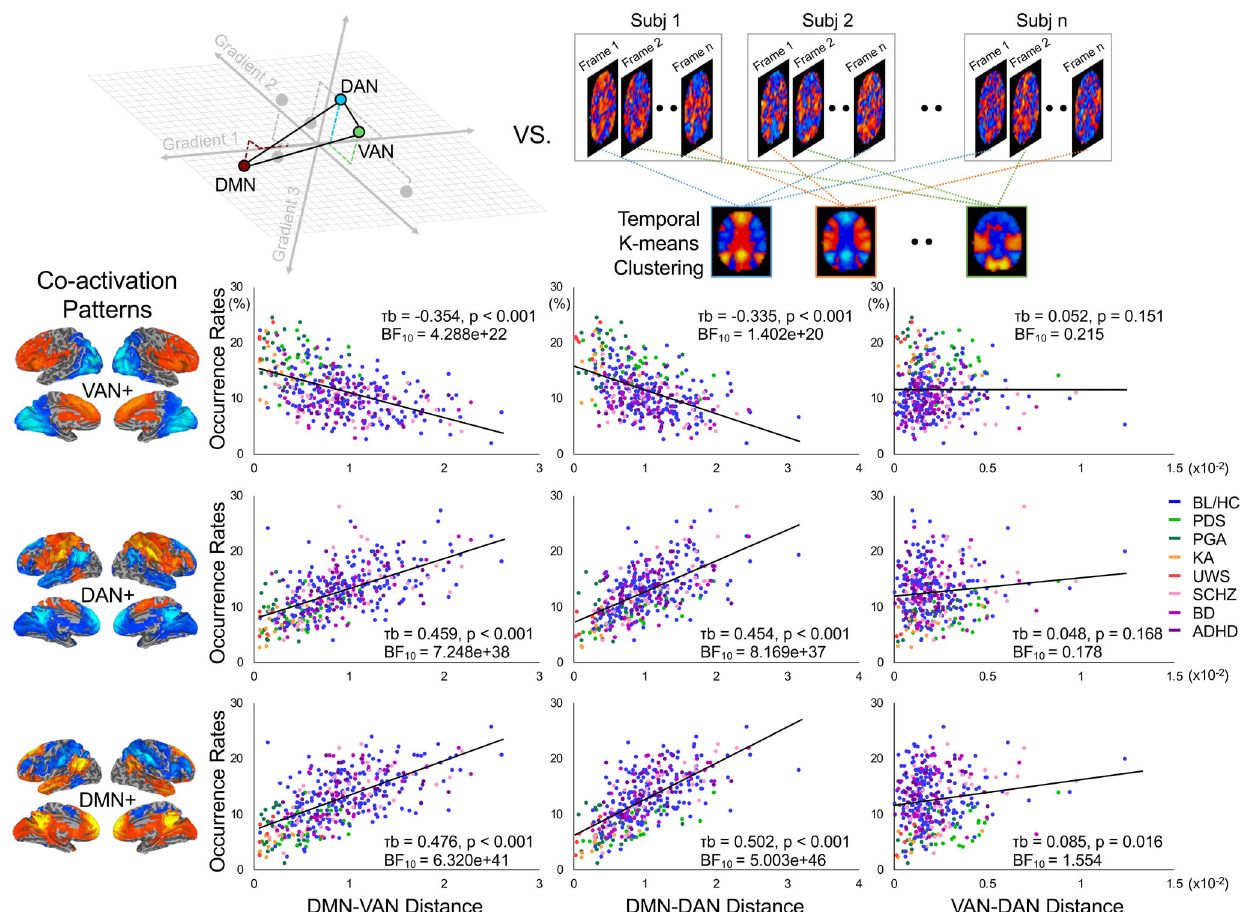
Fig. 6 | Correlation between-network distance and occurrence rates of co- activation patterns. Pair-wise network distance was calculated among ventral attention/salience network (VAN), dorsal attention network (DAN), and default- mode network (DMN). Co-activation analysis was applied to calculate their occur- rence rates, namely VAN+, DAN+, and DMN+. Bayesian Kendall Correlations were performed between-network distance (DMN-VAN, DMN-DAN, and VAN-DAN) and occurrence rates (VAN+, DAN+, and DMN+) across all participants and conditions ( n =393). Kendall ’ s tau-b ( τ b), FDR-corrected p values (at α =0.05), and BF 10 are